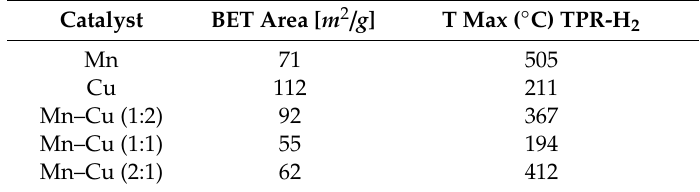
Table 3. Superficial area BET and maximum temperature values of reduction by TPR-H 2